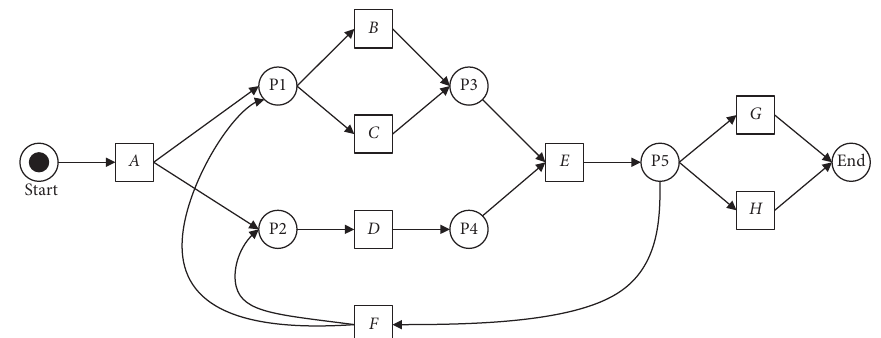
Figure 1: An illustrating example of process